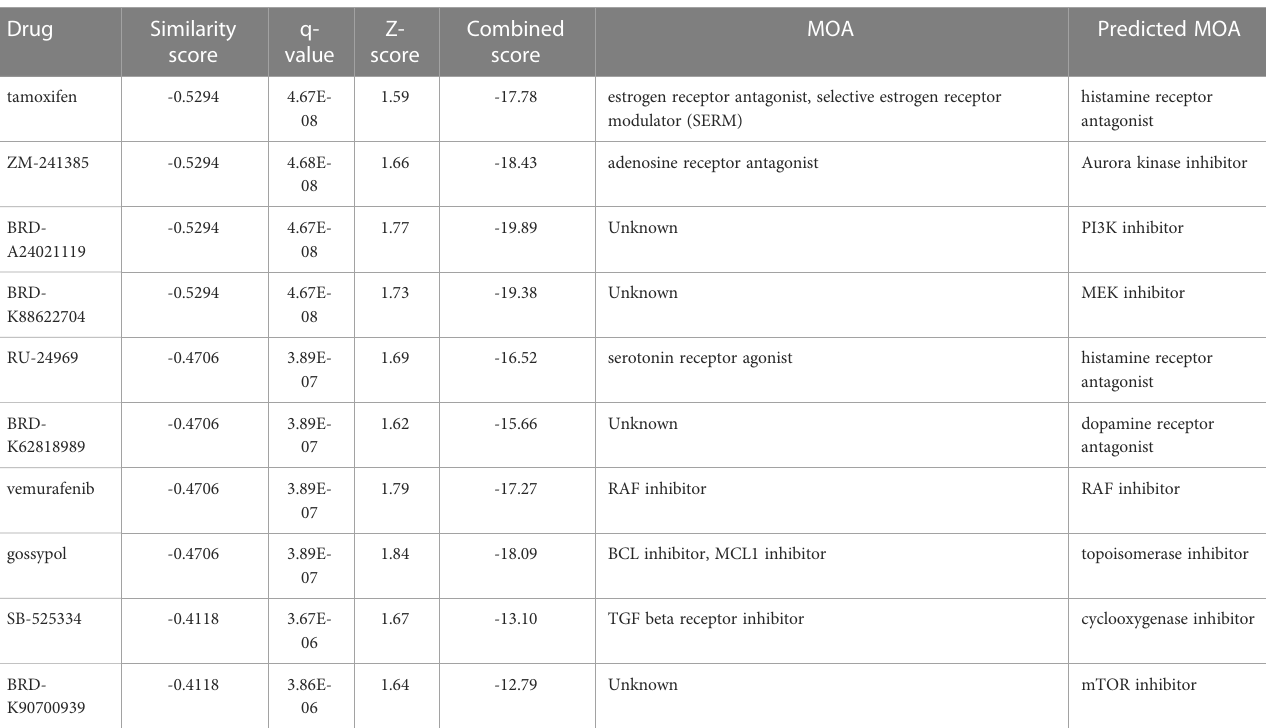
TABLE 2 Potential small molecule drugs screened for PAAD treatment.